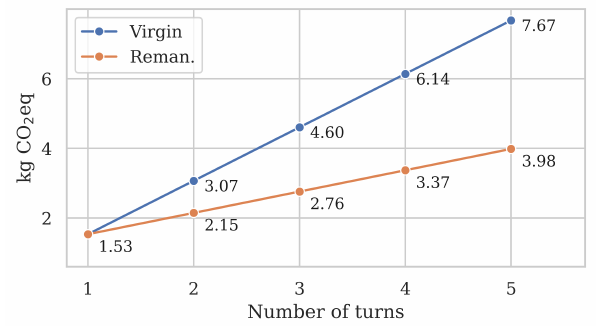
Figure 7. Sensitivity analysis of the number of turns N. Each remanufactured catheter has its first life as a virgin catheter with emission E f v . After that, remanufactured burdened per-life emissions E b increase by E f r per turn.